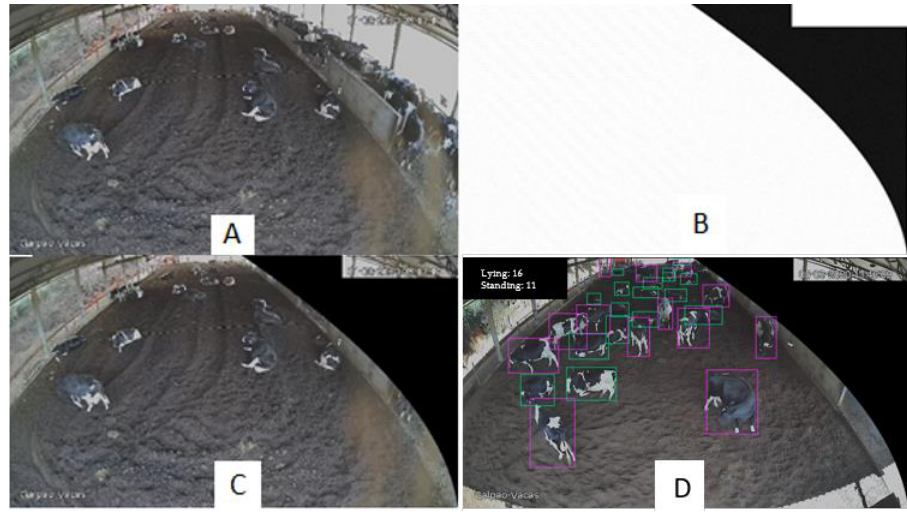
Figure 2. ( A ) Original image, ( B ) mask to remove the feeding aisle, ( C ) image used to train the algorithm and to count the animals, and ( D ) bounding boxes according to the animals’